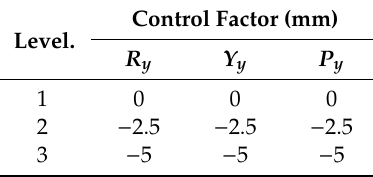
Table 3. Levels of control factors for the second experimental set. Level.